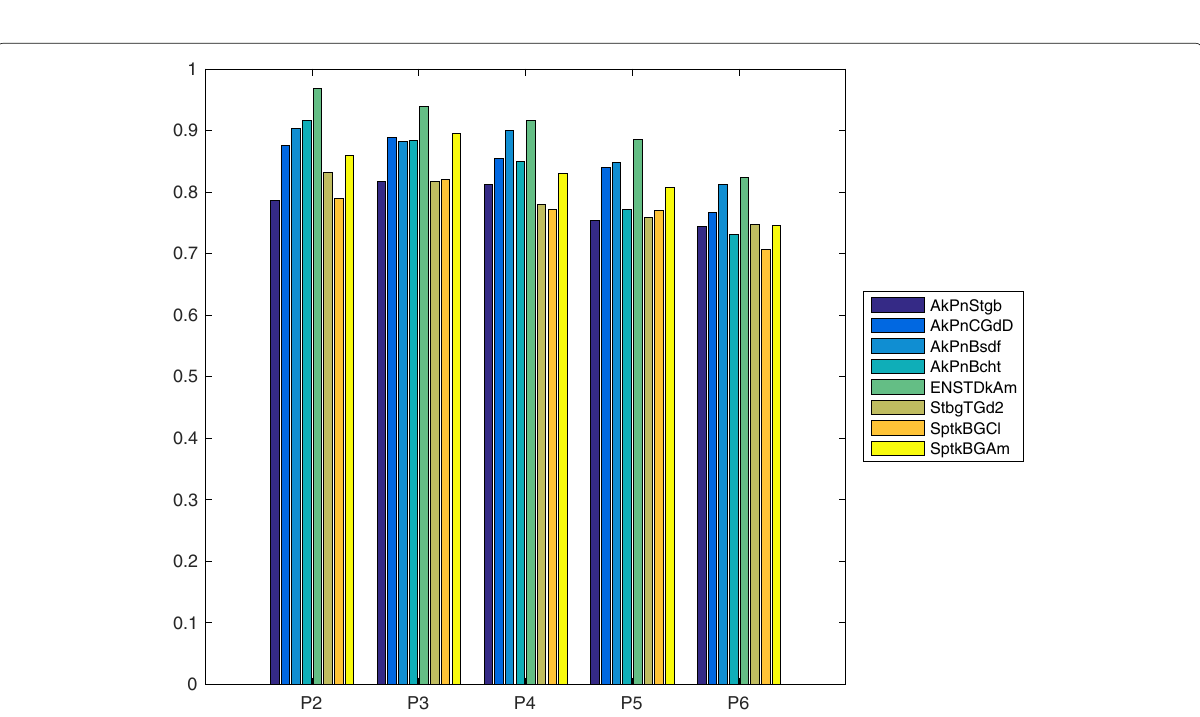
Fig. 13 F-measure results of timbre robustness